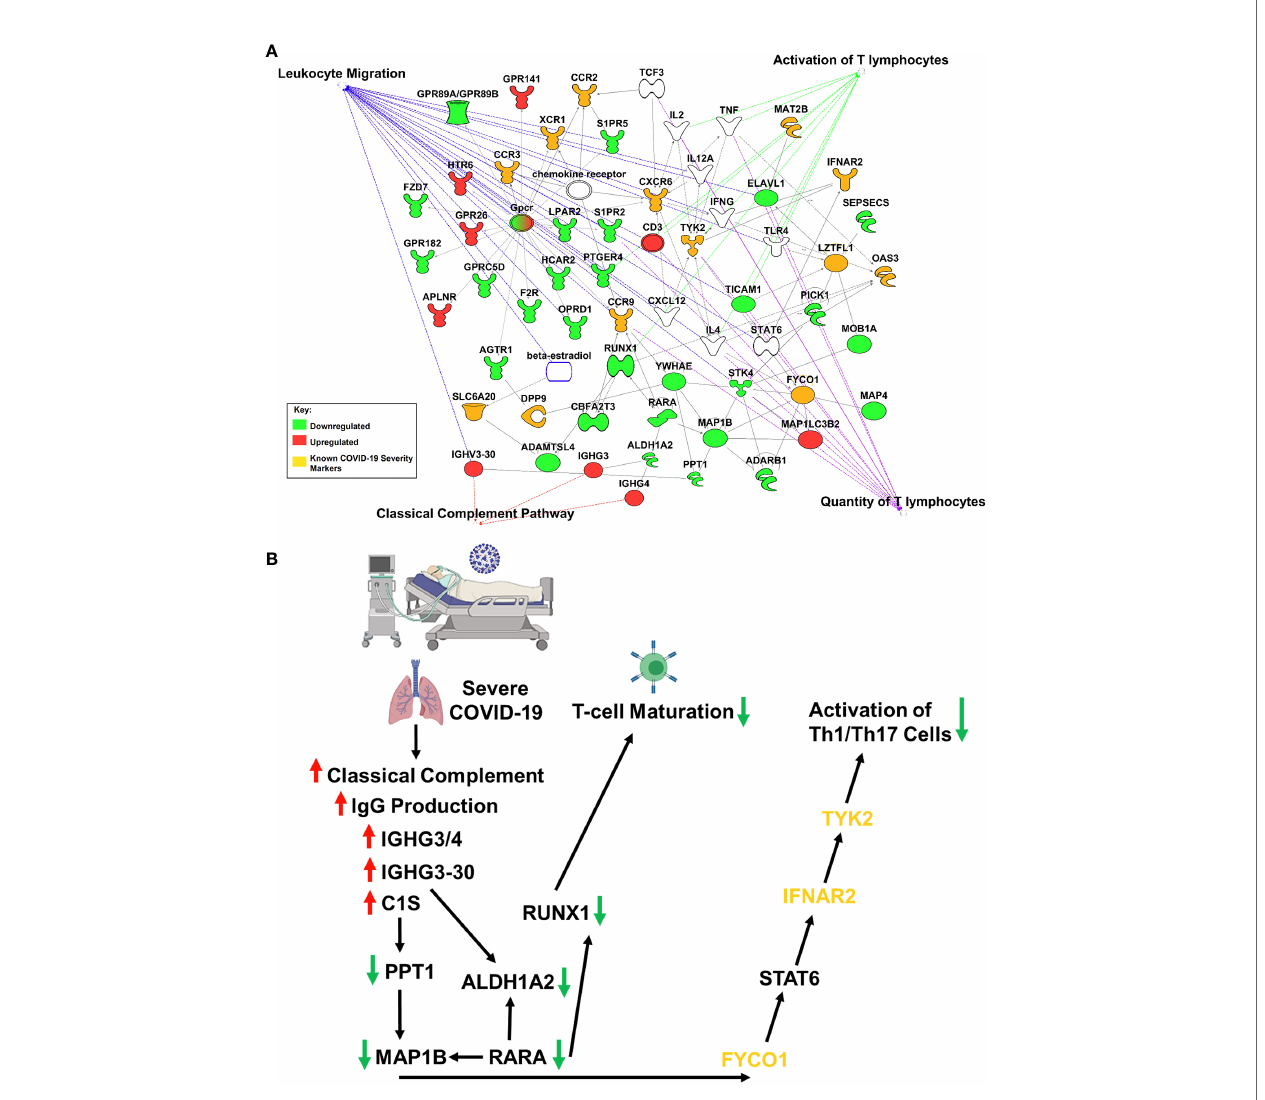
FIGURE 2 | IPA Network Analysis. (A) IPA generated network map showing known connections among the common genes found in both RNASeq datasets and the previously identi fi ed severe COVID-19 genetic susceptibility markers (SLC6A20, LZTFL1, CCR9, FYCO1, CXCR6, XCR1, DPP9, MAT2B, OAS3, TYK2, CCR2, CCR3, and INFAR2) with known pathways in IPA for cellular functions of interest. Genes are colored based on if the average gene expression between the two experiments showed upregulation (red) or downregulation (green). SLC6A20, LZTFL1, CCR9, FYCO1, CXCR6, XCR1, DPP9, MAT2B, OAS3, TYK2, CCR2, CCR3, and INFAR2 are all labeled in yellow. (B) COVID-19 causes upregulation of IgG production leading to activation of classical complement through C1S, which produces a downregulation of RUNX1 and TYK2 signaling, that blocks T-cell maturation and mutes Th1/Th17 immune response,